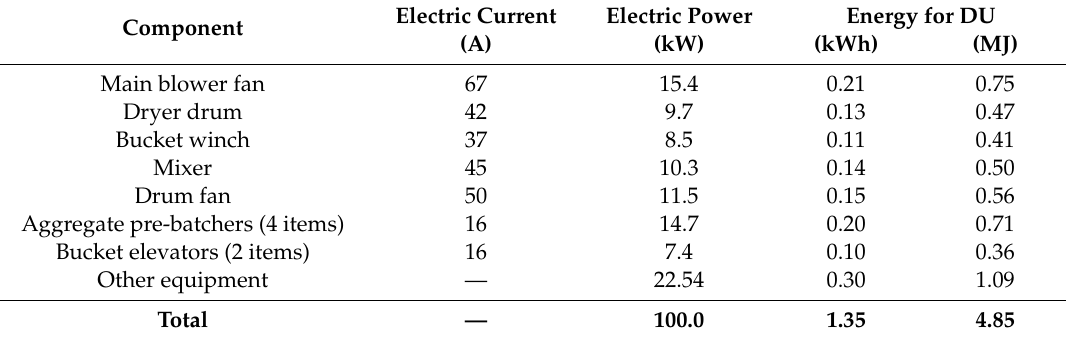
Table 5. Electric performance of main plant components: electric current, electric power and energy